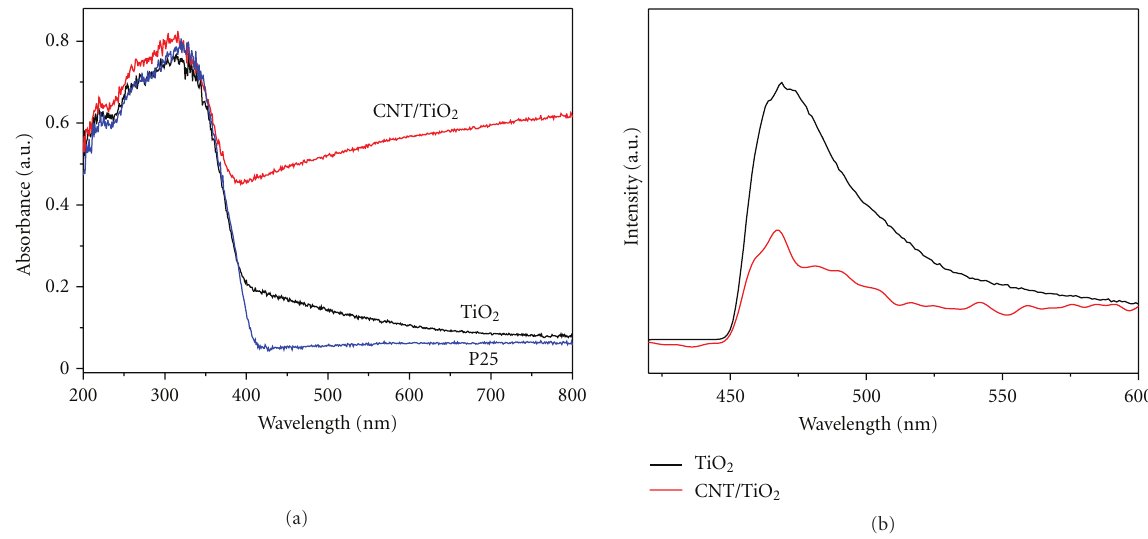
Figure 3: (a) UV-vis DRS spectra of the as-prepared TiO 2 nanoparticle, CNT/TiO 2 nanohybrids, and P25. (b) PL spectra of TiO 2 nanoparticle and CNT/TiO 2 nanohybrids.